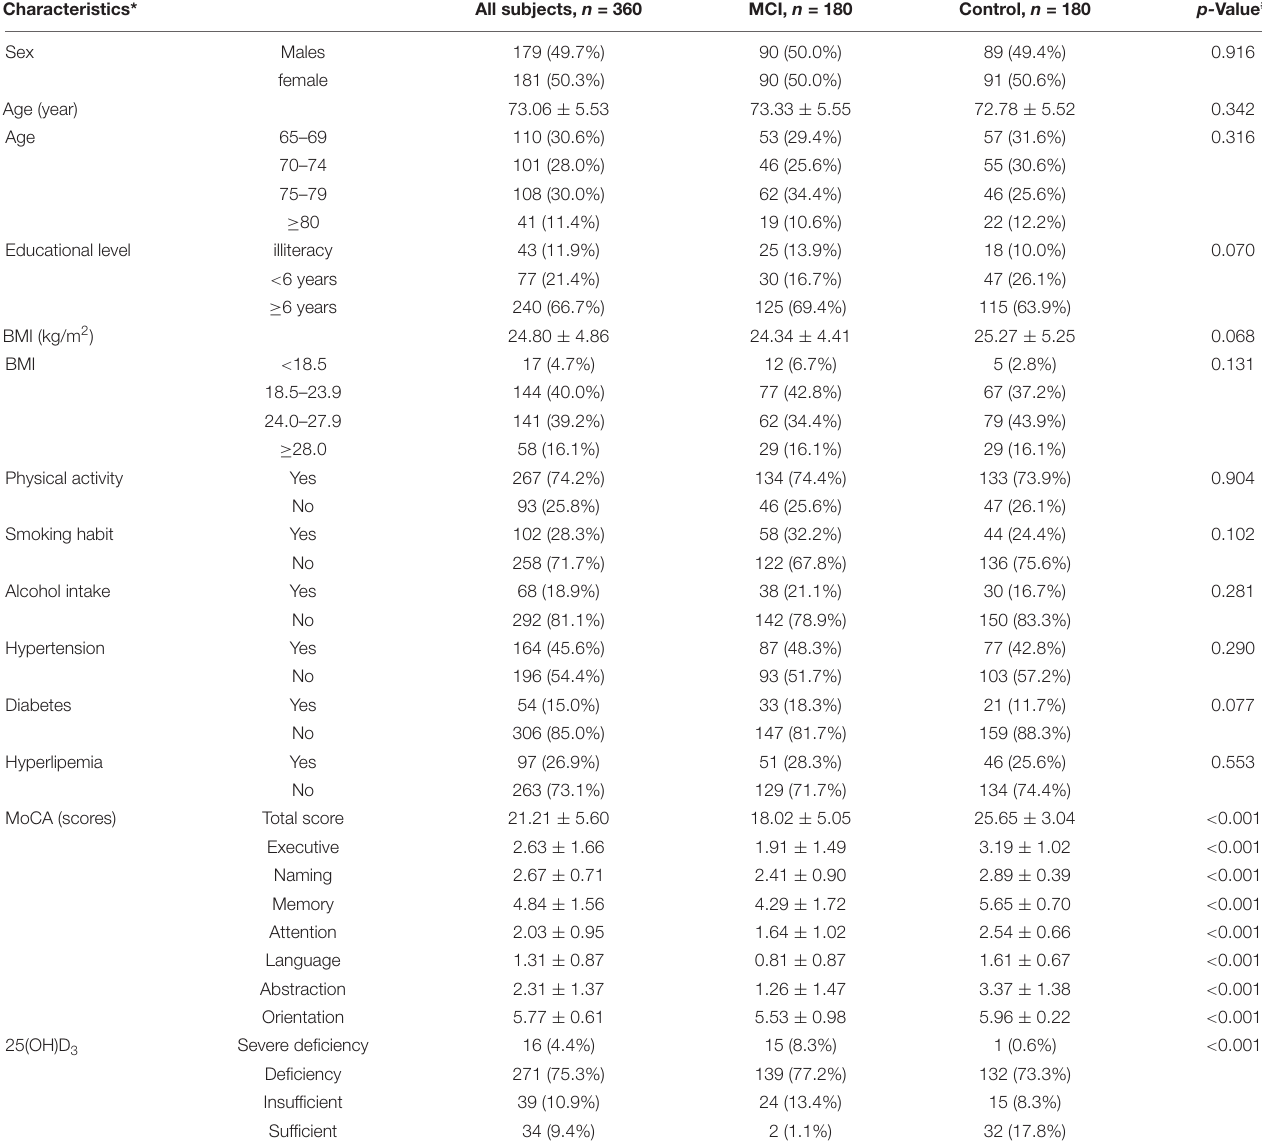
TABLE 1 | Characteristics of the study